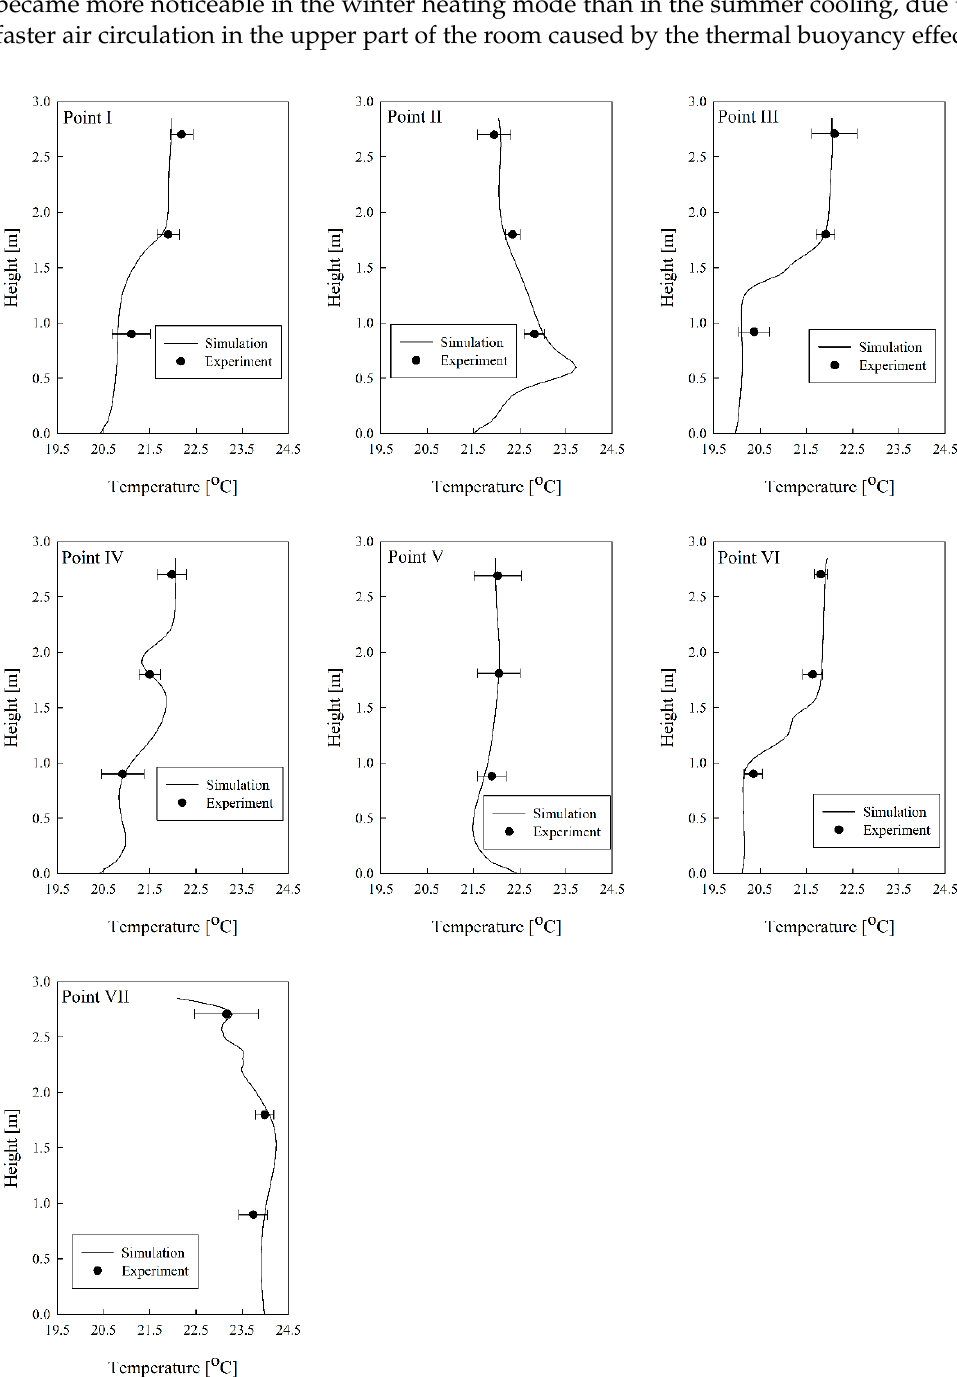
Figure 4. Comparison of experimental and simulation results for temperature distribution by height at seven locations in